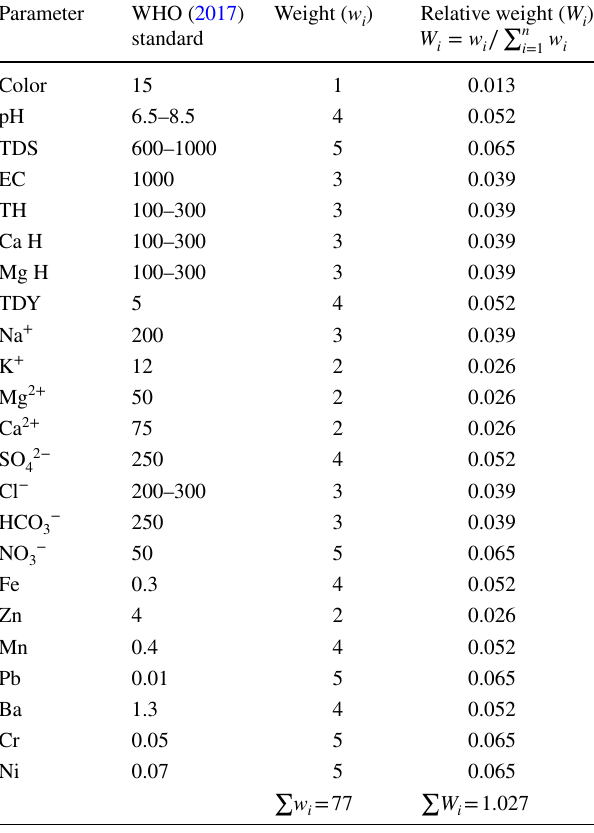
Table 9 Water quality index (WQI) classification for the individual